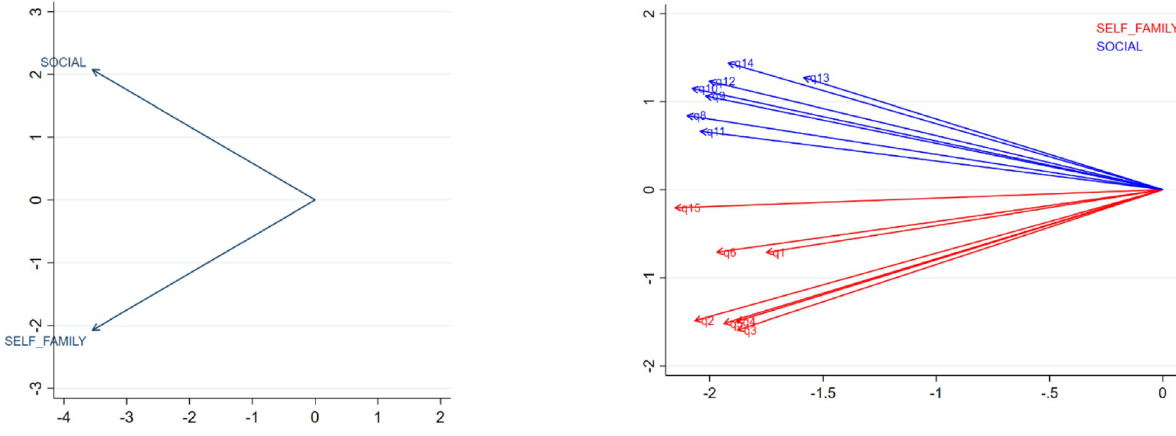
Fig 2. Correlation between domains (a) and items (b).